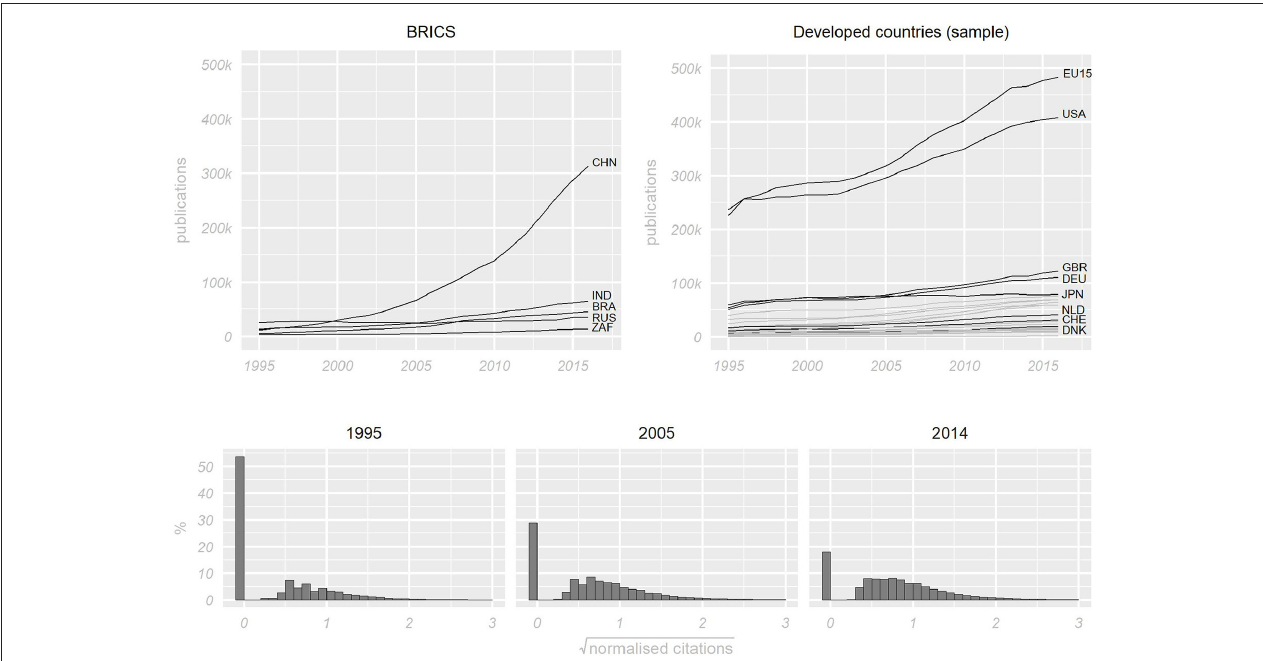
FIGURE 1 | (Upper left panel) Growth of national publications among BRICS countries; (Upper right panel) national publication growth of a sample of OECD countries; (Lower panel) yearly histograms of the normalized citations for Chinese publications (Data is truncated in the upper